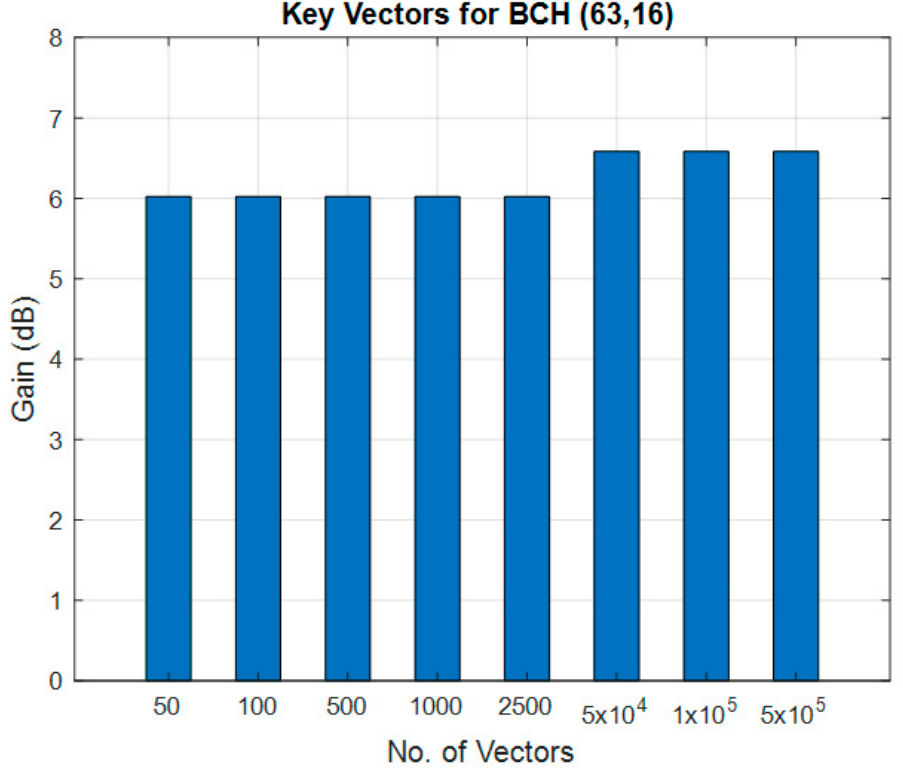
Figure 6. Possible PAPR gain from the most appropriate key obtained from a set of multiple random keys.